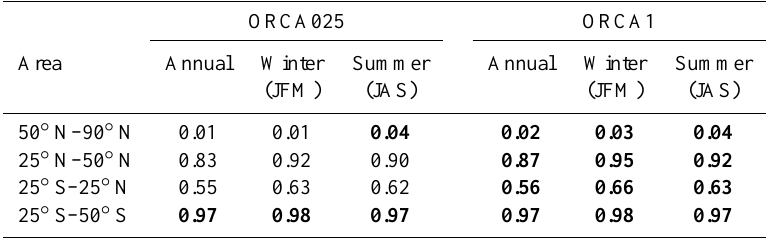
Table 1. Skill scores as defined by Taylor (2001) for each latitudinal band in the ORCA025 and ORCA1 experiments. The best scores reached are in bold.